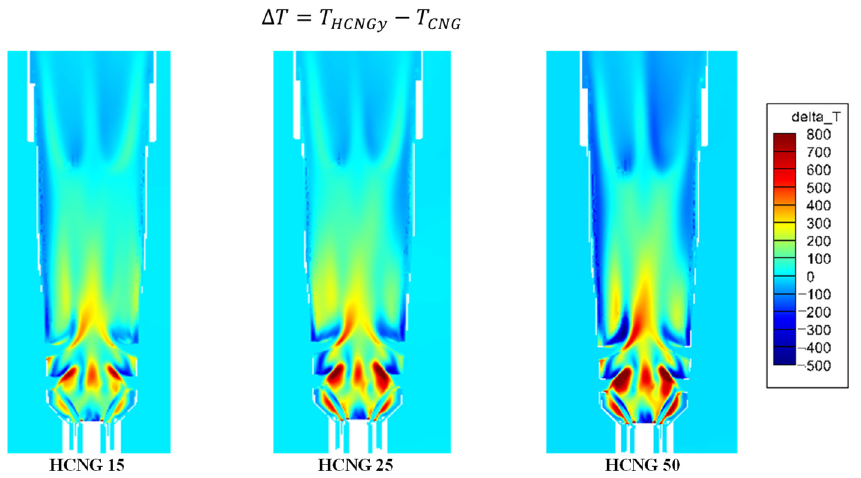
Figure 19. Differential temperature contours for HCNG fueling—slice 2.